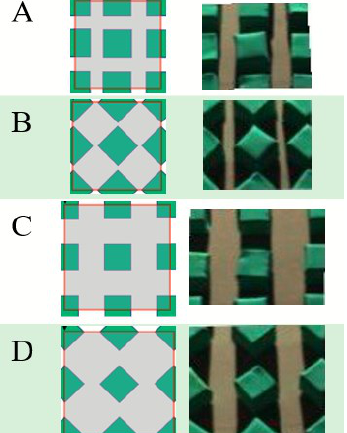
Figure 1 . The repetitive pattern in the four internal arrangments that we use to create dataset #1: schematic description of the patterns (left column) and the selected corresponding parts from the spectral images acquired from a vertical viewing direction (right column).